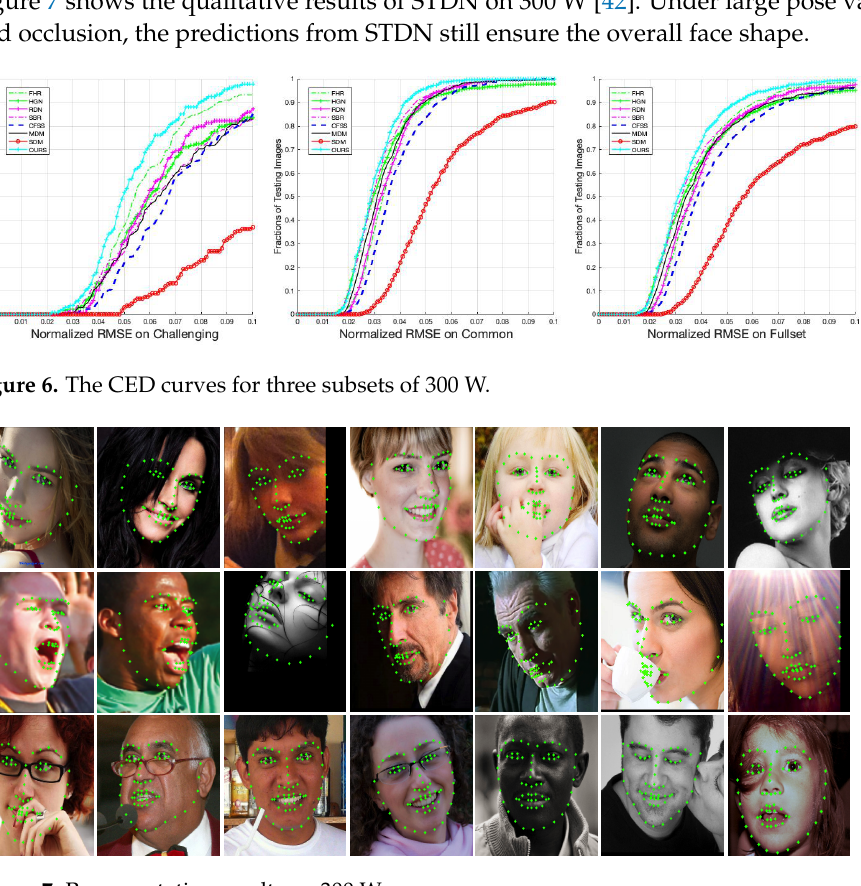
Figure 7. Representative results on 300